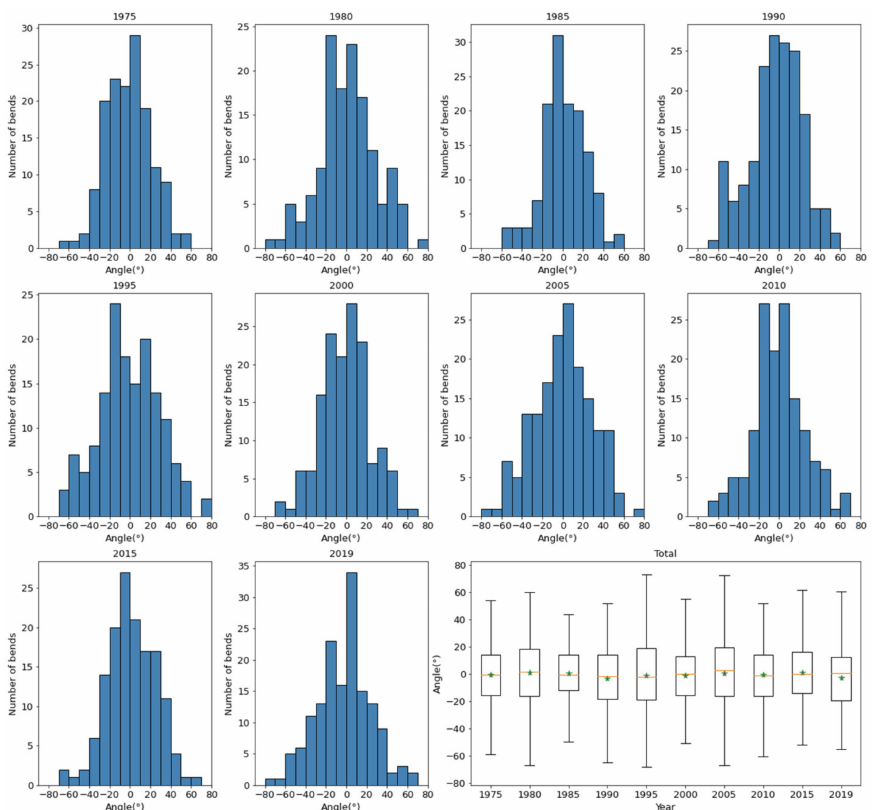
Figure 4. The measured meander wavelength in 1975, 1980, 1985, 1990, 1995, 2000, 2005, 2010, 2015, and